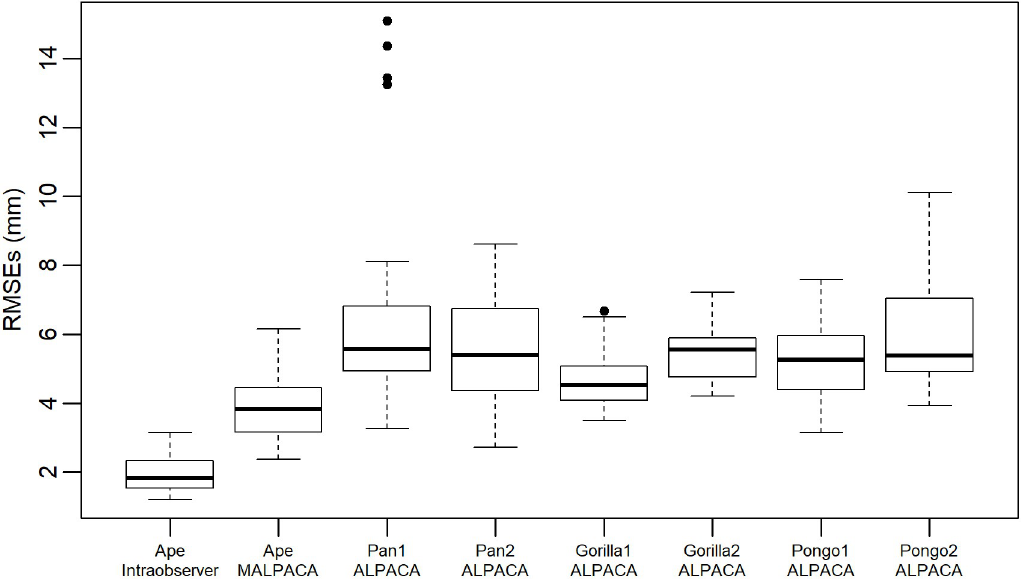
Fig 5. Comparison of RMSEs for the ape sample. RMSEs calculated between estimated landmarks and the GS landmarks. Each column represents the RMSEs of 46 ape specimens calculated by a specific analysis. “Ape Intraobserver” refers to the RMSEs between two manual landmark datasets of the ape sample. See S4 Fig for RMSEs as percentage of centroid sizes. See S2 Table for the template used for each ALPACA based on a K- means selected template.